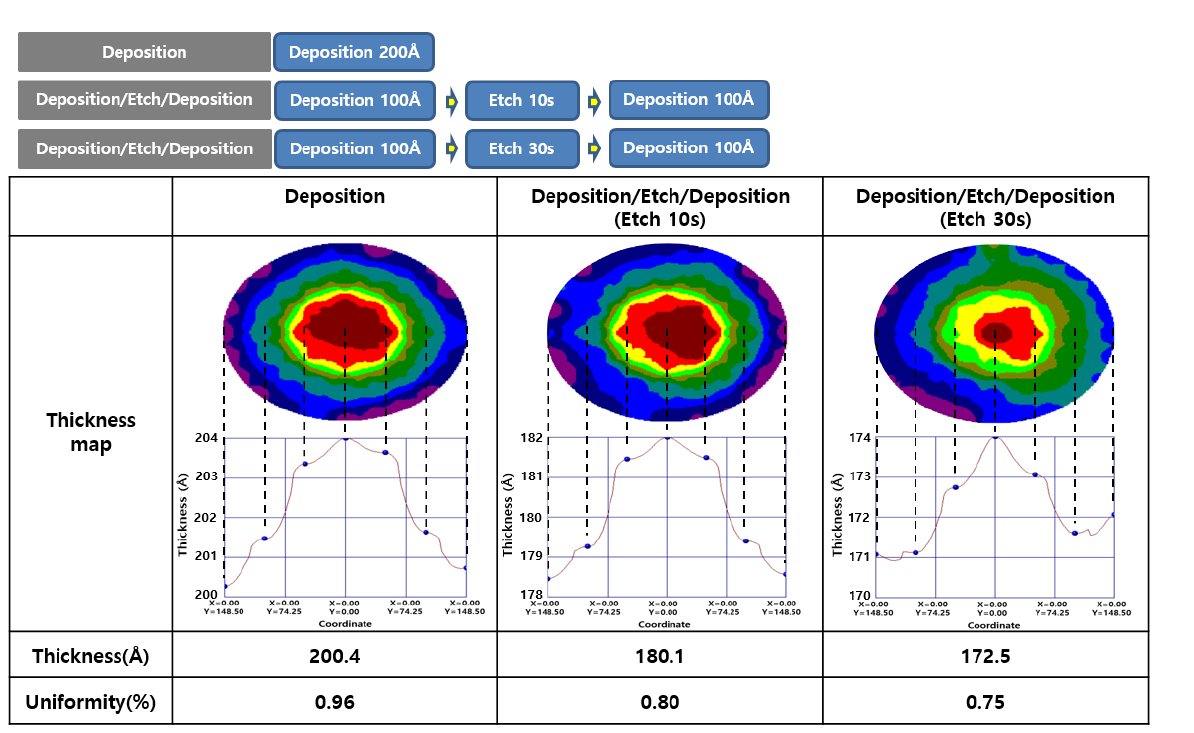
Figure 7. The thickness and uniformity of the silicon oxide thin film deposited via the DED method on a flat plate.